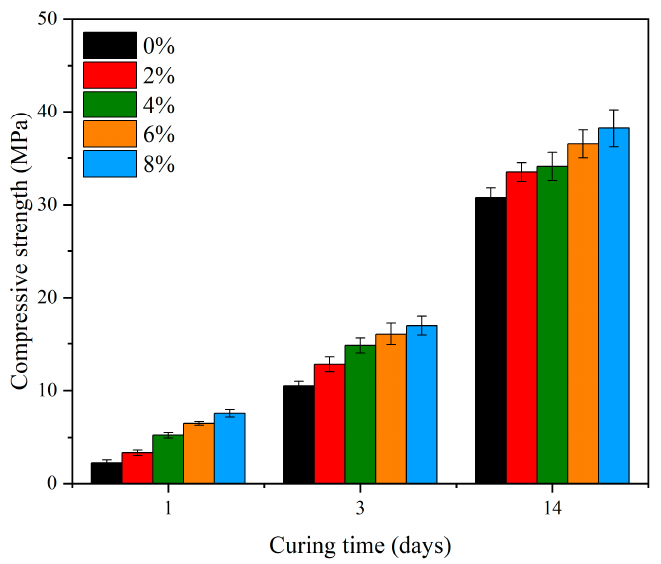
Figure 4. Compressive strength of cement samples with ultrafine calcium silicate.